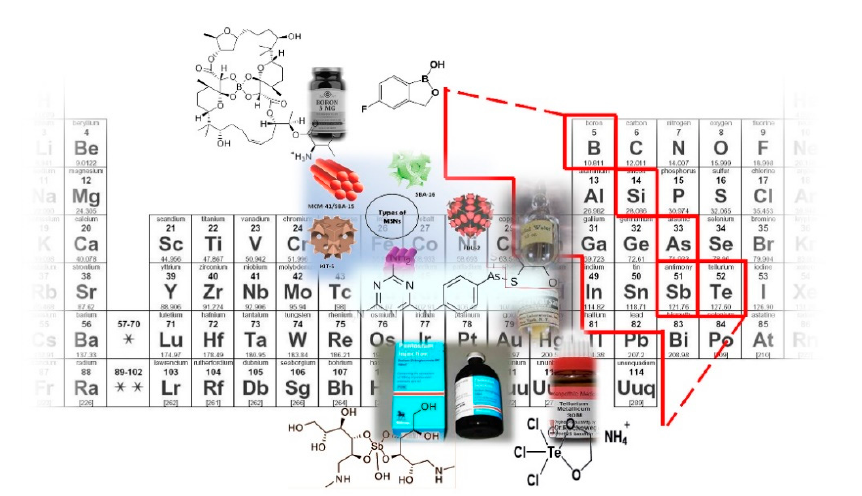
Figure 1. The periodic table highlighting the elements considered for the purposes of this article. The group of metalloids with application in the field of anti-infective therapy (B, Si, As, Sb, Te) is indicated by the red line.